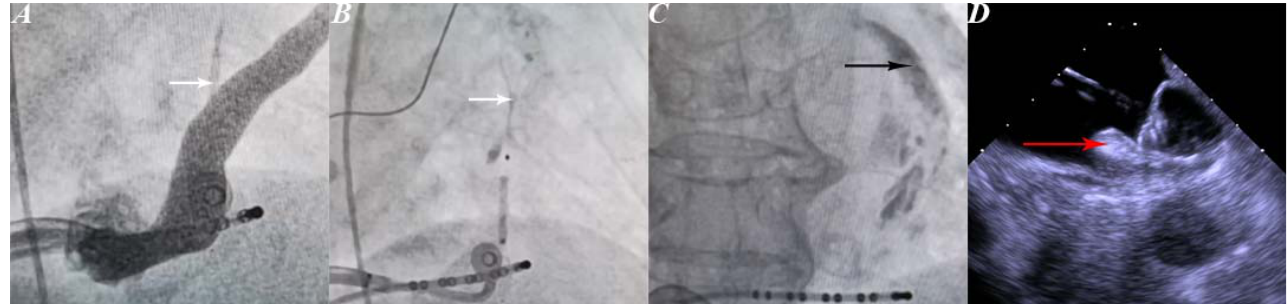
Figure 1. Steps of the procedure. Panel ( A ) VOM (white arrow) in Coronary sinus venogram. Panel ( B ) Vein of Marshall venogram was performed after the balloon was inflated to reveal the anatomy of the VOM (white arrow). Panel ( C ) Contrast infiltration (black arrow). Panel ( D ) Watchman closure implantation. Prominent edema of the coumadin ridge (red arrow) in the echocardiographic image. VOM, vein of Marshall.